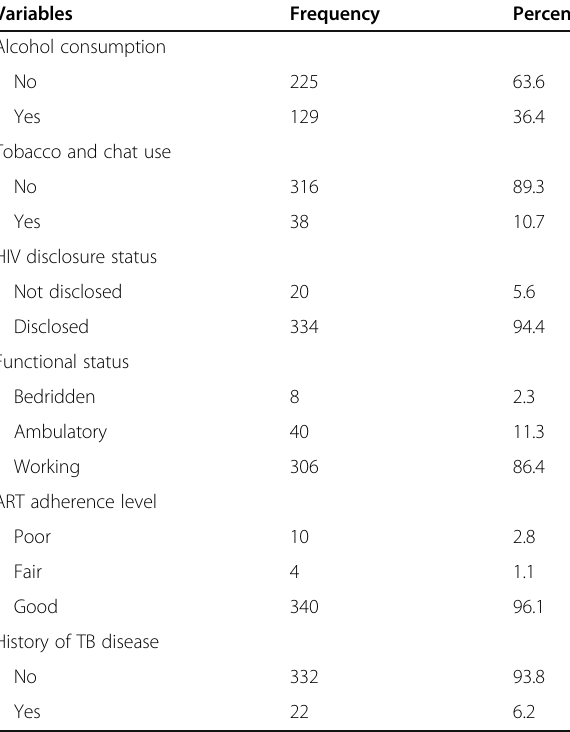
Table 2 Summarized information on HIV/AIDS patients ’ clinical and risk behavior factors under ART (University of Gondar teaching hospital, 2009 –